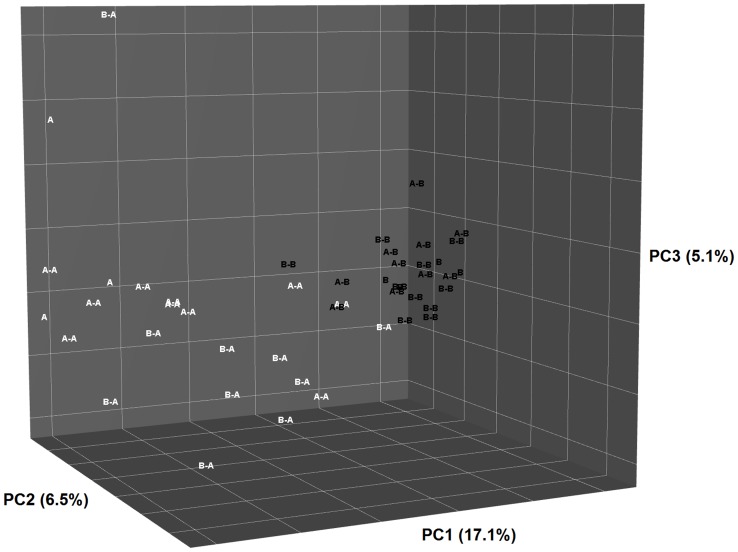
Principal Coordinate Analysis plot of unweighted Unifrac phylogenetic distances showing the similarities between bacterial communities of queens fed Diet A or Diet B and their offspring fed Diet A (B-A or A-A) or Diet B (B-B or A-B) post-weaning.Percentage of variation captured by each component indicated on axes.